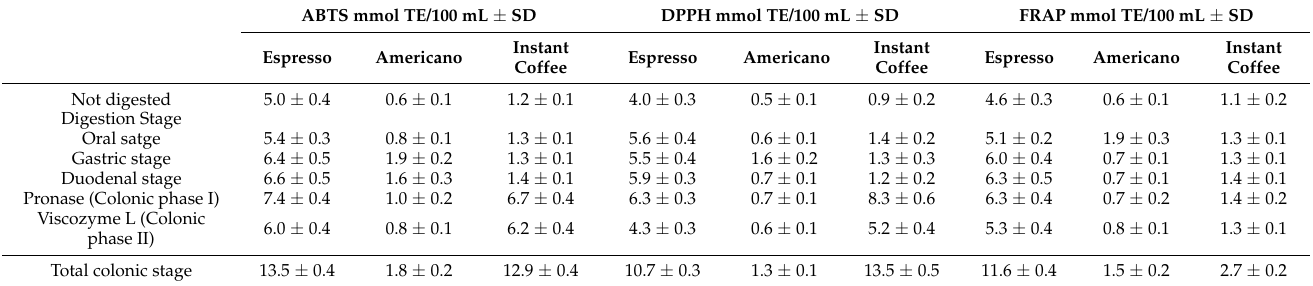
Table 4. Antioxidant capacity evaluated by ABTS, DPPH, and ferric reducing/antioxidant power (FRAP) procedures of not-digested and digested samples.